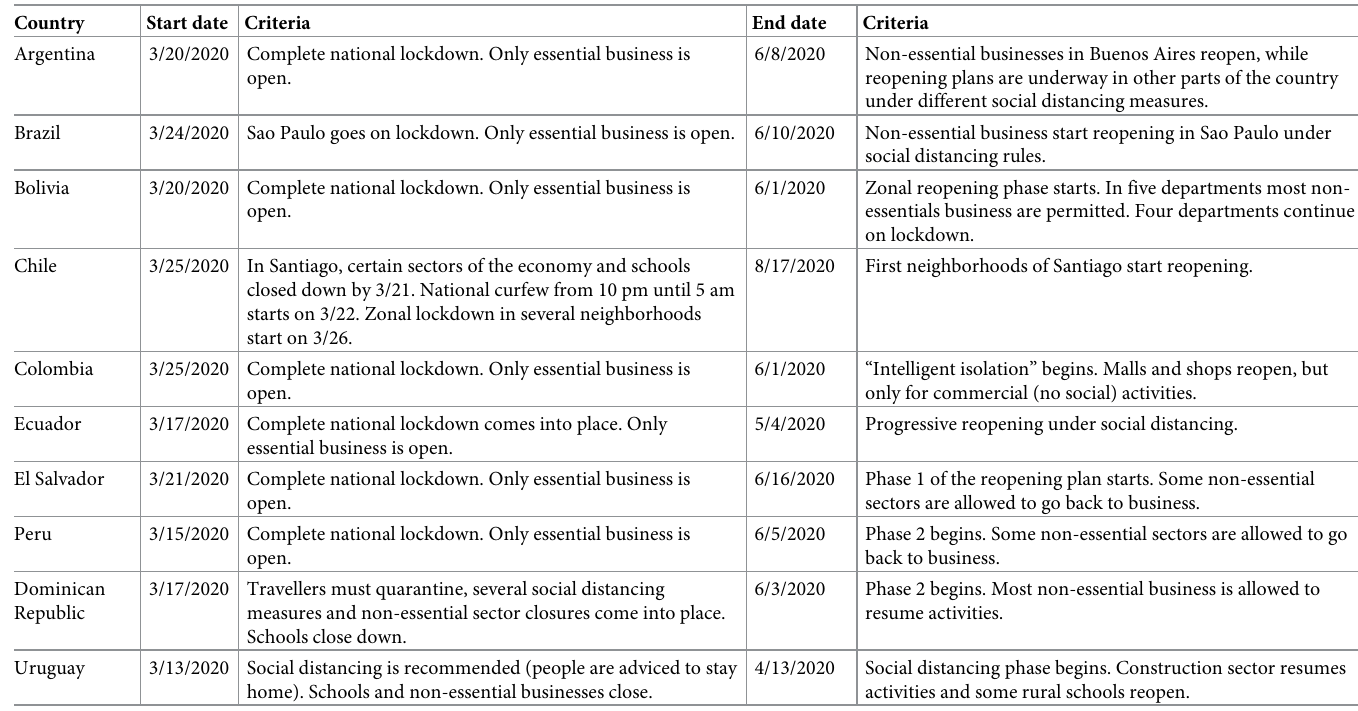
Table 4. Dates of full